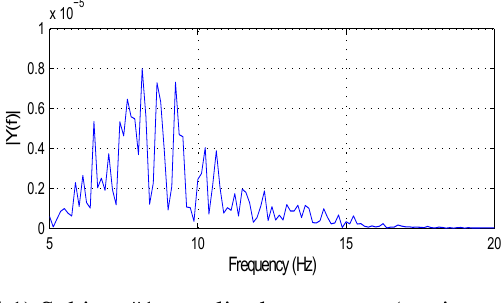
(a1)Surgeon #1, amplitude spectrum (pointing task) (b1) Subject #1, amplitude spectrum (tracing task)